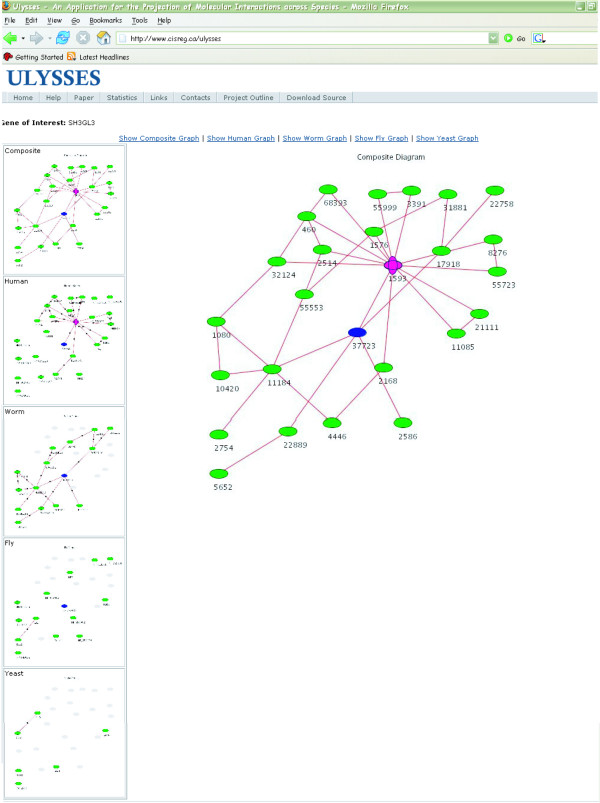
Screenshot of the Ulysses interface. The user-specified protein is shown in blue, and interacting proteins are displayed in green. Proteins with greater than three interactions (the 'starburst' threshold) are marked with a magenta-colored cross. The colors and 'starburst' threshold are user-adjustable parameters. Species-specific interactions are displayed in the panel of windows on the left. In this figure, the central graph displays a composite image identifying each node with its HomoloGene identifier. By selecting a species window, the species-specific interactions will be displayed along with the identity of the individual protein interactors.